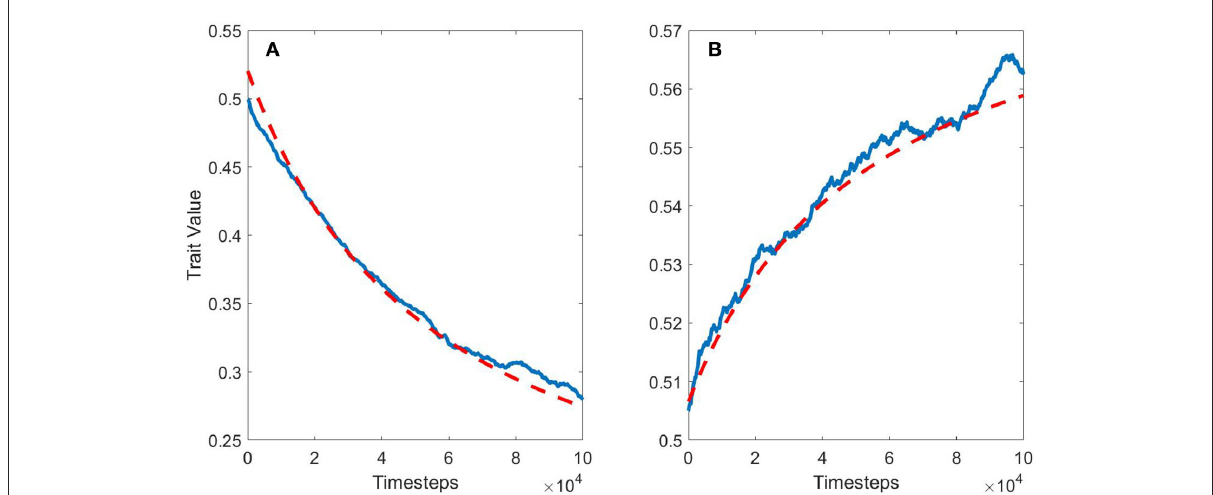
FIGURE2 The blue line is the average trait evolution for 200 model runs, the red dashed line is the predicted evolution by Equation (4). For the set of runs in (A) , mutation bias pressures the trait value down while the environment is biased to larger trait values. The environment changes over time. (B) Is identical, but without mutation bias, allowing environmental bias to push the trait value